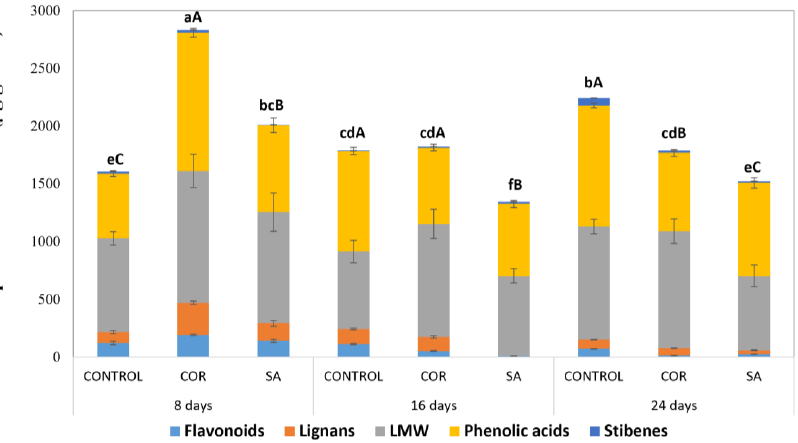
Figure 5. Semi − quantification of the total phenolic content (TPC) in the extracts from T. baccata cell suspensions either untreated (control) or elicited with 1 μM coronatine (COR) or 150 μM salicylic acid (SA) at all the experimental time points (days 8, 16, and 24). Flavonoid content expressed as μg of luteolin equivalents per gram of dry weight (μg LE/g DW). Lignan content expressed as μg of sesamin equivalents per gram of dry weight (μg SE/g DW). Low − molecular − weight phenolic con- tent expressed as μg of tyrosol equivalents per gram of dry weight (μg TE/g DW). Phenolic acid content expressed as μg of ferulic acid equivalents per gram of dry weight (μg FE/g DW). Stilbene content expressed as μg of trans − resveratrol equivalents per gram of dry weight (μg RE/g DW). Vertical bars indicate standard deviation (n = 6). Lowercase letters indicate significant differences ( p < 0.05) within treatments between experimental time points. Capital letters indicate significant dif- ferences ( p < 0.05) between treatments within the same experimental time point. The statistical dif- ferences were evaluated according to Tukey’s honestly significant different test.